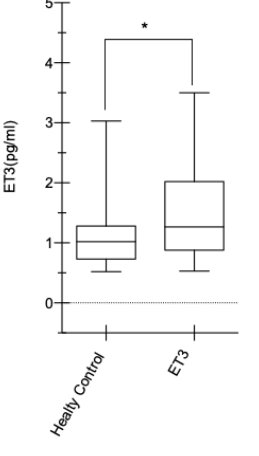
Figure 1: Endothelin-3 (ET3) plasma levels determined from healthy (control) subjects and multiple sclerosis patients (mean ± standard deviation). Statistical significance was demonstrated using Mann- Whitney (two-tailed) *p = 0.0329.